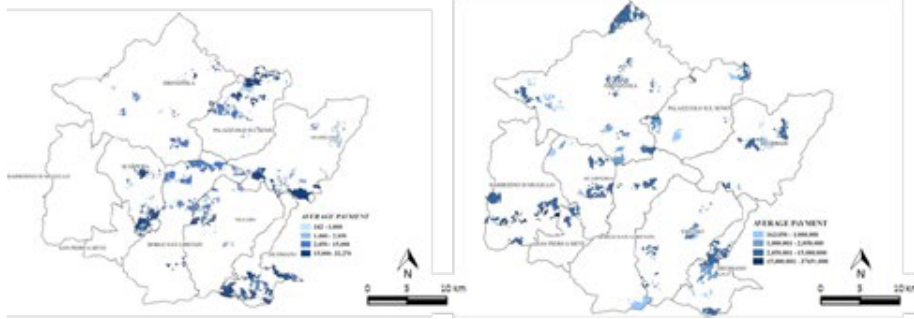
Figure 9. Average payment (euro) related to areas with development problems (measure 211, left, and 212, right), in